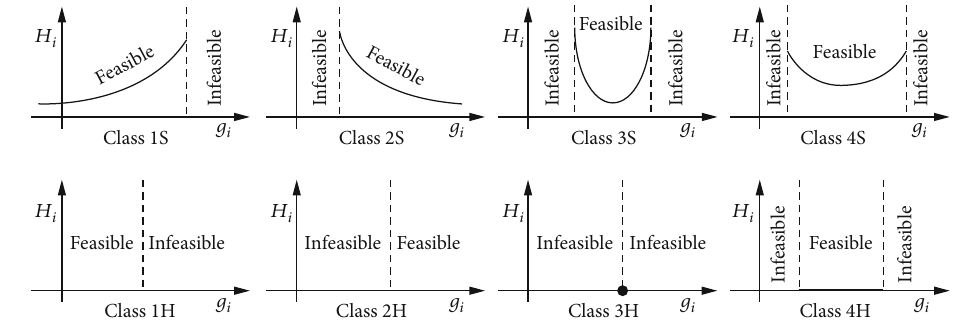
Figure 5: Preference function classi fi cation for physical programming.